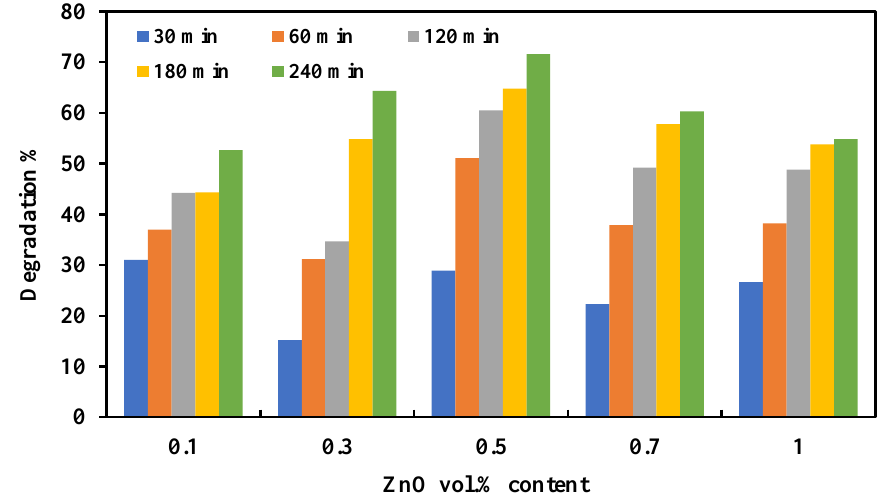
Figure 6: Photodegradation efficiency of MB dye (10ppm) by ZnONPs/epoxy nanocomposite with different volumes of ZnONPs.